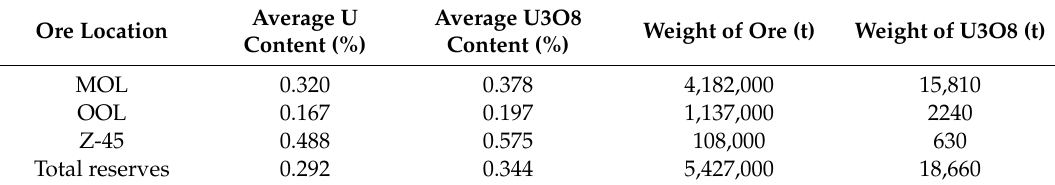
Table 3. The reserves level of the deposit of Kuriskova [61].